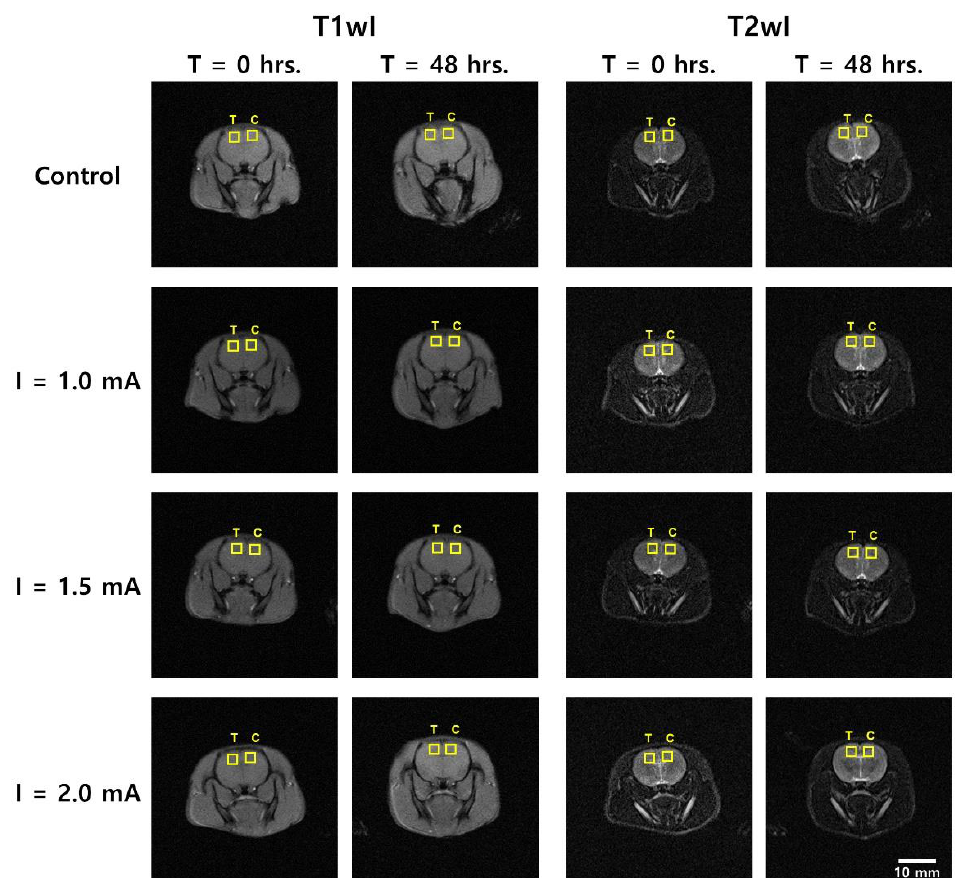
Figure 2. Longitudinal T1- and T2-weighted magnetic resonance images of rat brains acquired immediately (0 h) and 48 h after tACS with a frequency of 10 Hz and a treatment time of 20 min. Yellow boxes in MR images indicate regions segmented for quantitative analysis of mean intensity values. (T: Transcranial alternating current stimulation-applied region, C: Contralateral region).